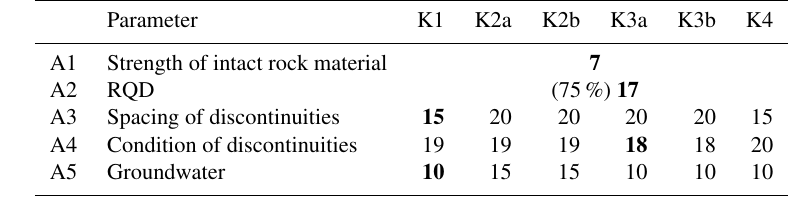
Table 4. Parameters used for RMRb determination. Chosen index values are bold.